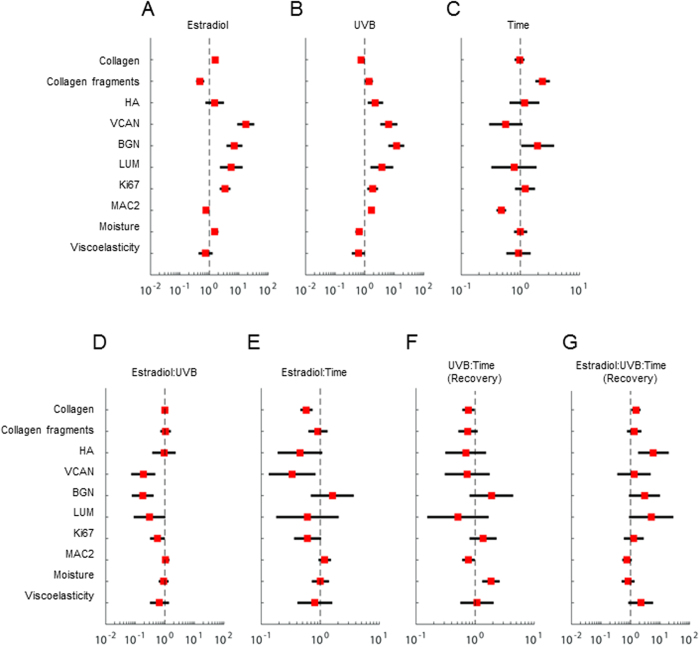
Statistical analysis of matrix associated aging processes.Odds ratios. Estradiol, UVB, and Time treatment effects on viscoelasticity, moisture, MAC2, Ki67, LUM, BGN, VCAN, HA, Collagen Fragment, and Collagen depicted as odds ratios (red) with 95% confidence intervals (black horizontal lines). Panel A–C: main effects of treatments on matrix components and functional skin parameters. Panel D–G: effects caused by interaction between treatments.